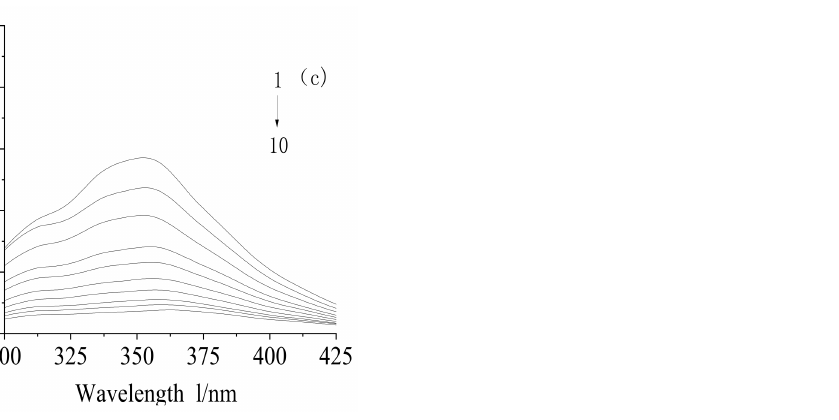
Figure 1. Fluorescence emission spectra in the MC-TPS interaction system under different tempera- tures. ( a ): 298 K, ( b ): 303 K, ( c ): 308 K; pH = 7.40. C (TRP) = 3 × 10 − 5 mol/L; C (MC) (1–10): 0, 0.5, 1, 1.5, 2, 2.5, 3, 3.5, 4, 4.5 × 10 − 4 mol/L.